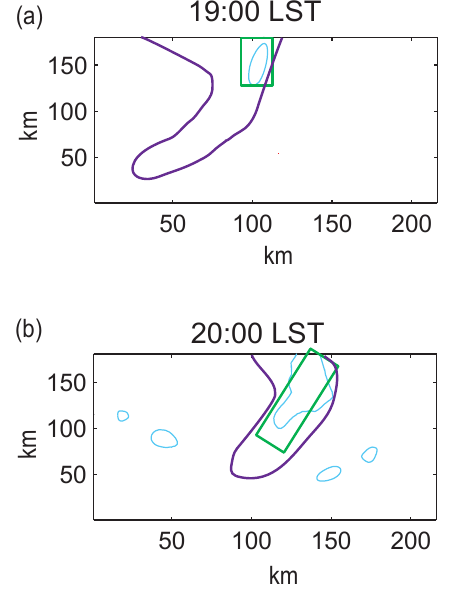
Figure 9. Boundary of each area which has the observed surface precipitation rate of 60mmh − 1 or above (blue contours) and a spe- cific area (surrounded by the green rectangle in the control run and described in the text related to Fig. 8) where heavy precipitation is concentrated in the control run in Domain 3 at (a) 19:00LST and (b) 20:00LST. Purple lines are the same as in Fig.